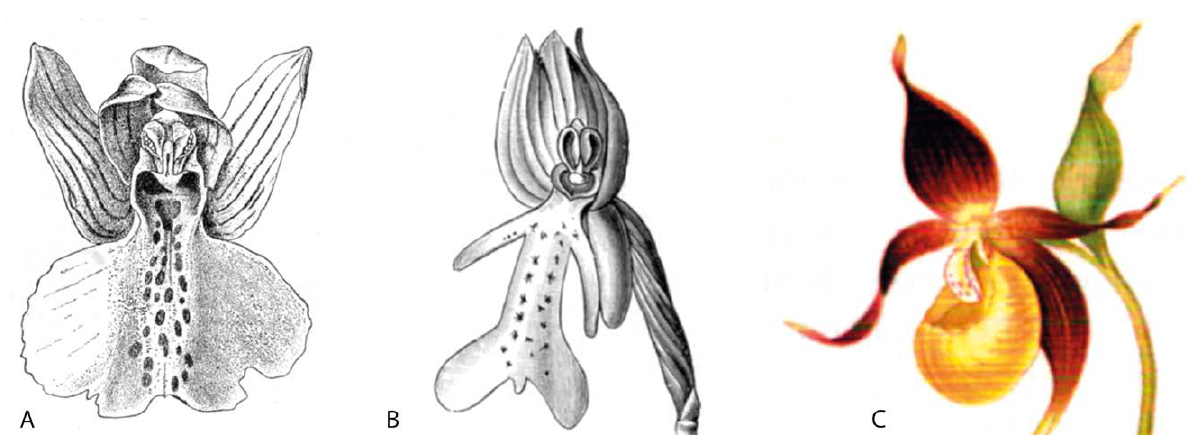
Figure 1. Three different types of orchid flowers, which represent their great variation in pattern. The shape of the flower is not related to any obvious advantage to the organism. (A) Orchis Morio , Green-winged orchid. An example of a flower with the general shape. (B) Orchis militaris , Manikin orchid or Military orchid. In this species the flower’s ”lip” resembles the human body with: head, open arms and open legs. (C) Cypripedilum acaule , Lady’s slipper. Another species in which the ”lip” resembles a shoe or a